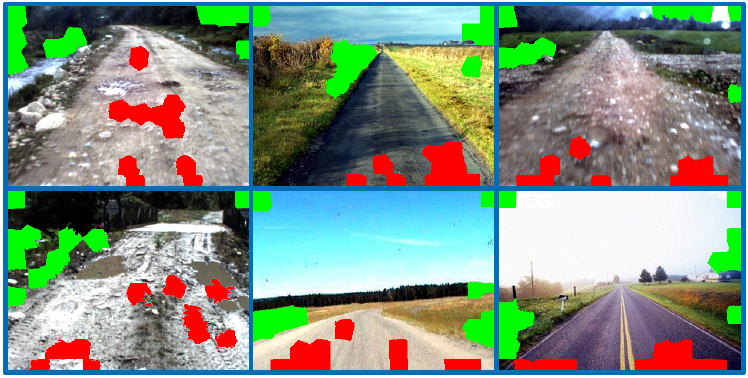
Figure 10. The selection of superpixel-level background seeds above a vanishing line: ( a ) test road image; ( b ) superpixels above the vanishing line (colored in red); ( c ) the result of the selection (colored in yellow).